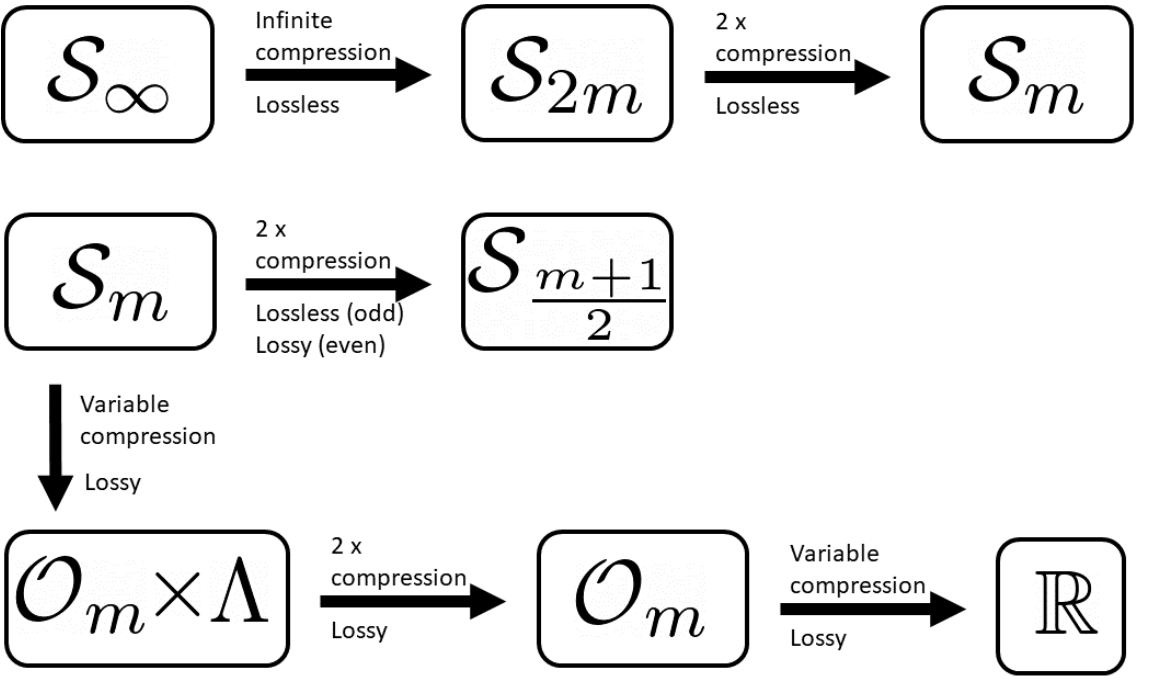
Figure 1. Schematic of the various sets discussed in this work and their relationships. Top row : Lossless compression of information about the sequence of triangular numbers modulo m based on Theorems 1–3. Second row : Application of Theorem 4. Note for odd values of m , this information compression is lossless. It is lossy, however, when m is even. Bottom row : Mapping of the ordered sequences in S m to the unordered sets. As the order is lost, these maps are lossy. Data compression is dependent on the specific value of m . This data compression finally results in the representation of the sequence of triangular numbers modulo m as saturation, 0 ≤ s ≤ 1 via Definition